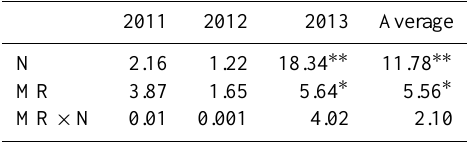
Table 2. Results ( F Values) of two-way ANOVAs on the effects of N addition (N), moss removal (MR) and their interactions on CH 4 flux (gCH 4 m − 2 h − 1 ) .